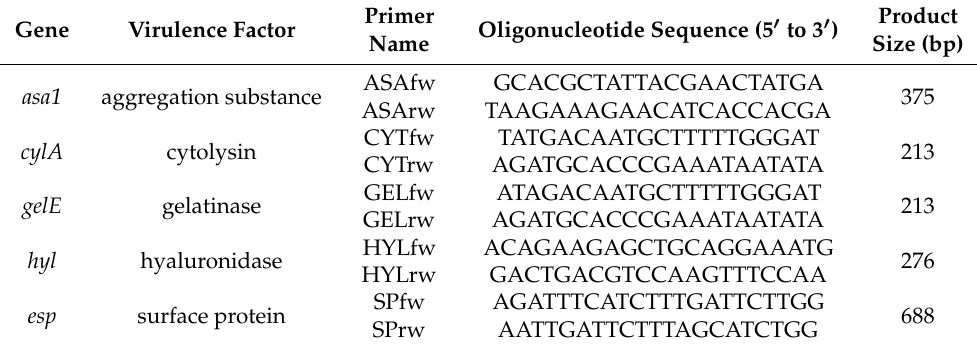
Table 1. PCR primers used for the detection of virulence